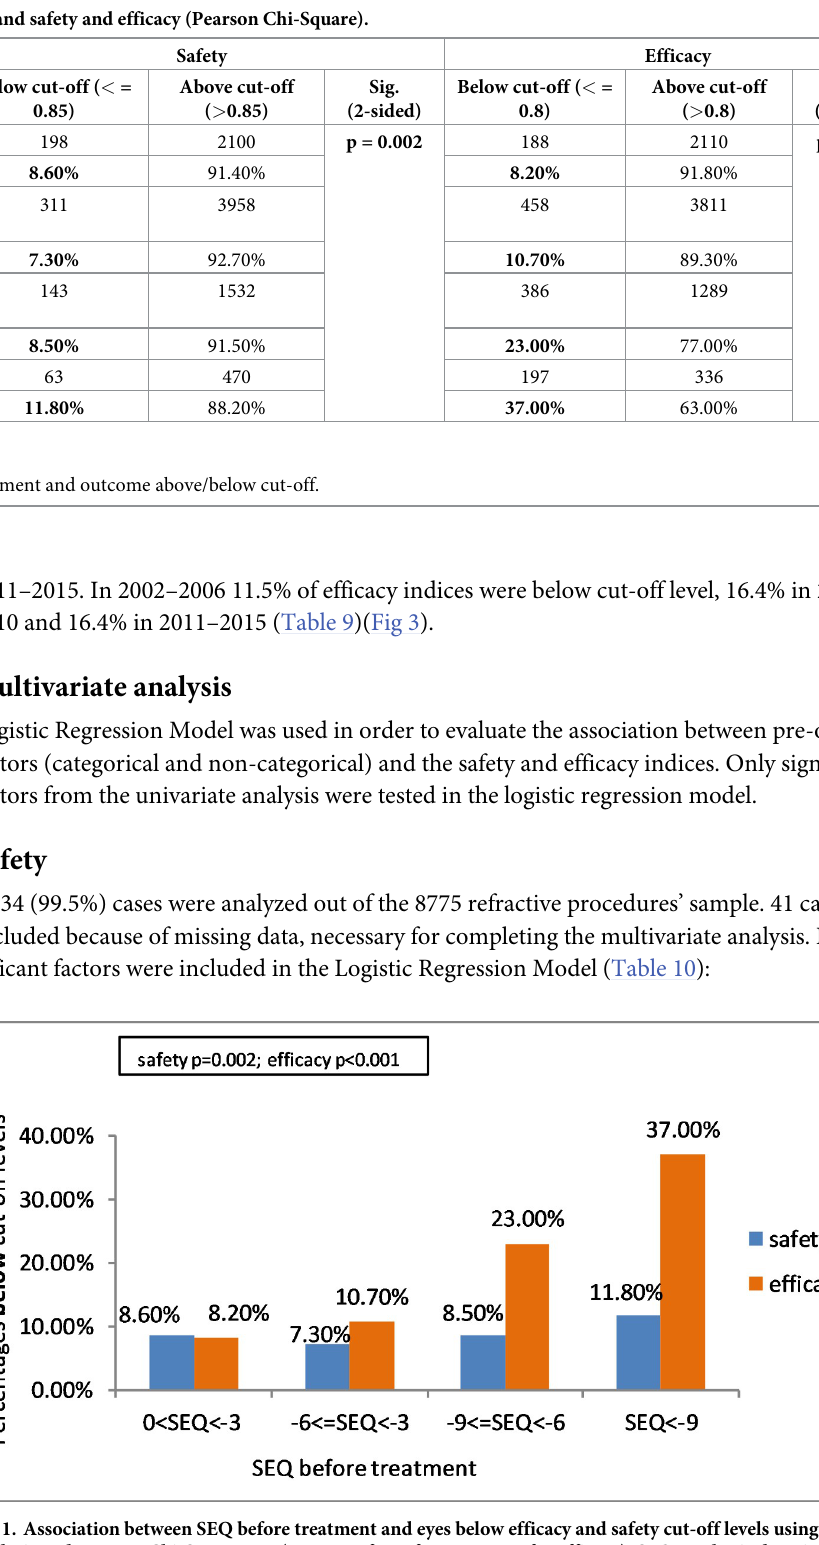
Table 6. Correlation between SEQ before treatment and safety and efficacy (Pearson Chi-Square).